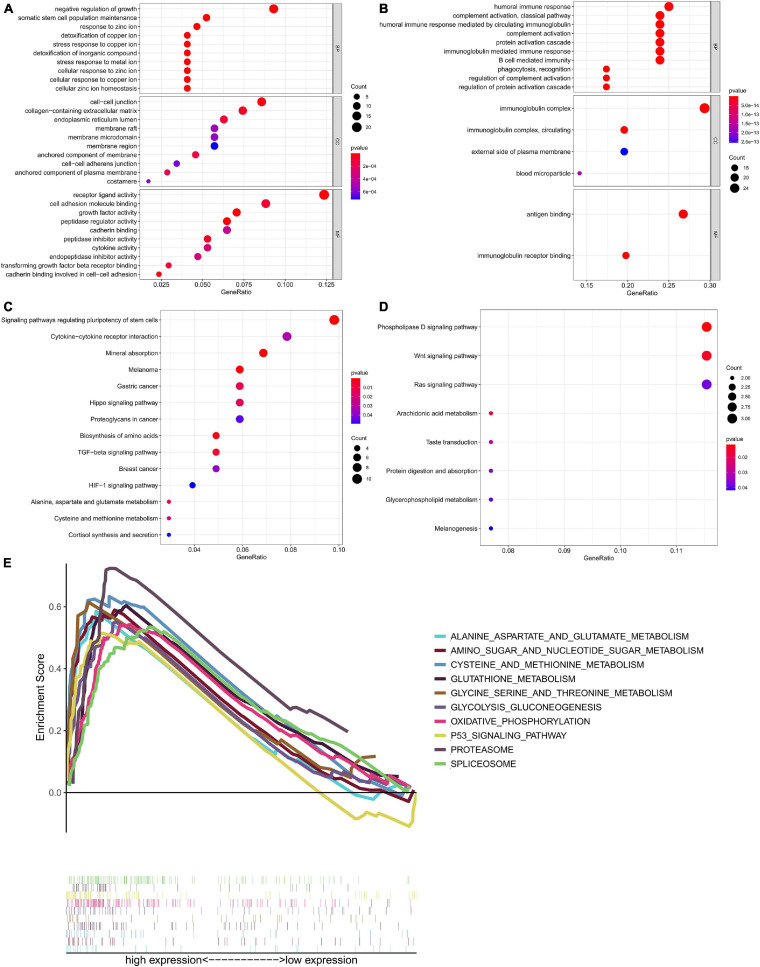
Functional annotation of the differentially expressed genes between high risk and low risk groups based on six-RBP risk score of TGCT in TCGA cohort. Bubble plots showed enrichment of (A) GO terms associated with up-regulated genes and (B) GO terms associated with down-regulated genes. Bubble plots showed enrichment of (C) KEGG pathway associated with up-regulated genes and (D) KEGG pathway associated with down-regulated genes. (E) GSEA analysis showed the top ten most significantly enriched signaling pathways in high-risk score subgroup. GO, Gene Ontology; KEGG, Kyoto Encyclopedia of Genes and Genomes.